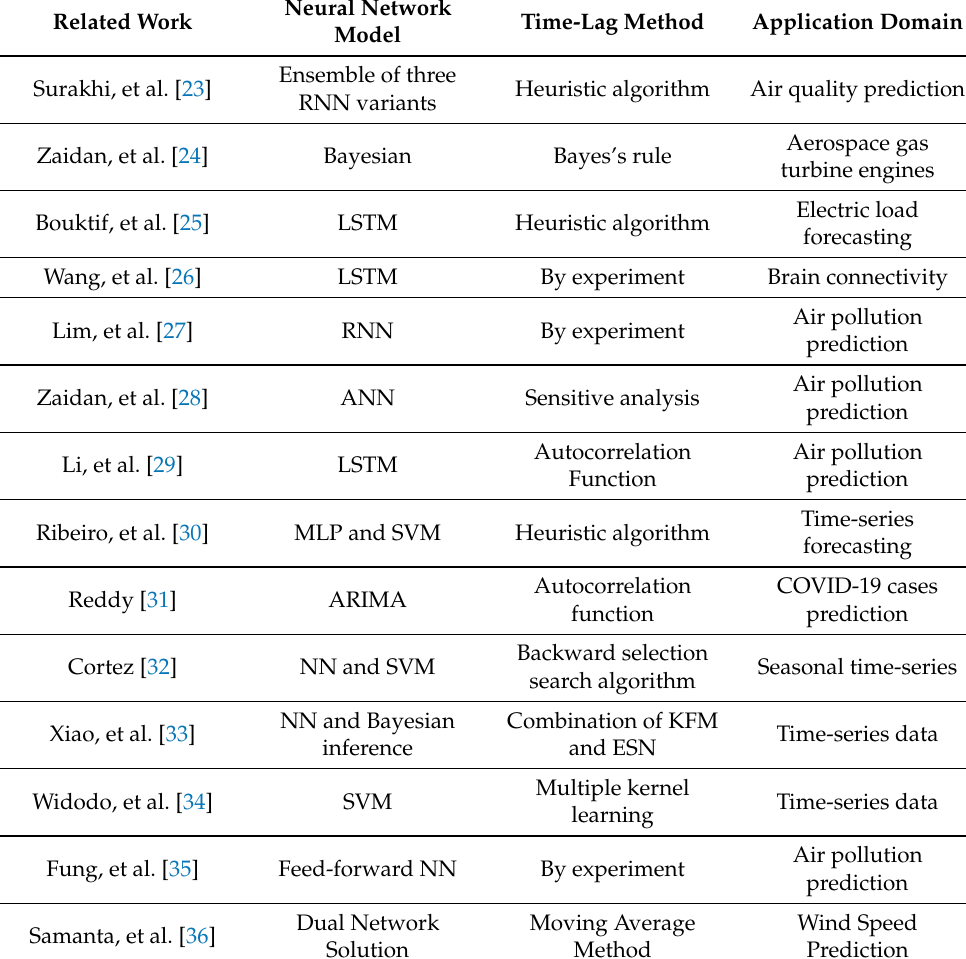
Table 1. A list of related works in the